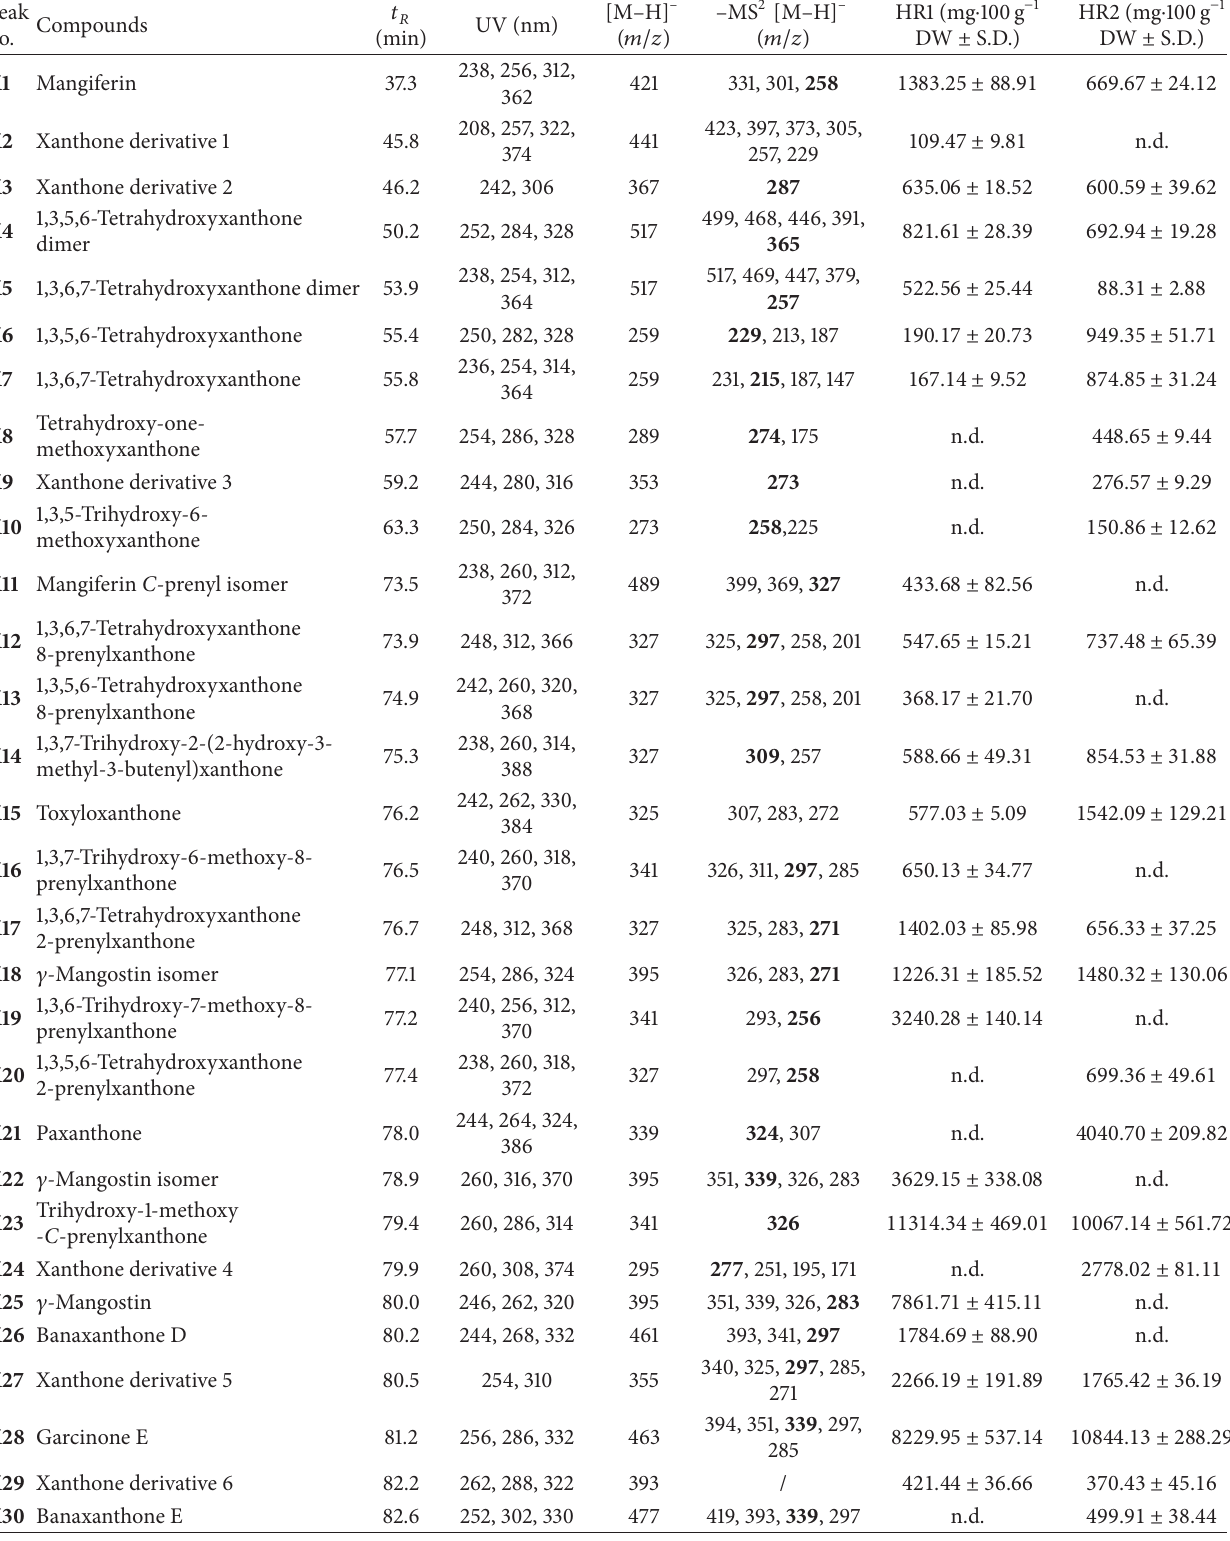
Table 2: Retention times, UV, and mass spectral data of xanthones in Hypericum perforatum dark-grown (HR1) and photoperiod-exposed (HR2) hairy root culture extracts a